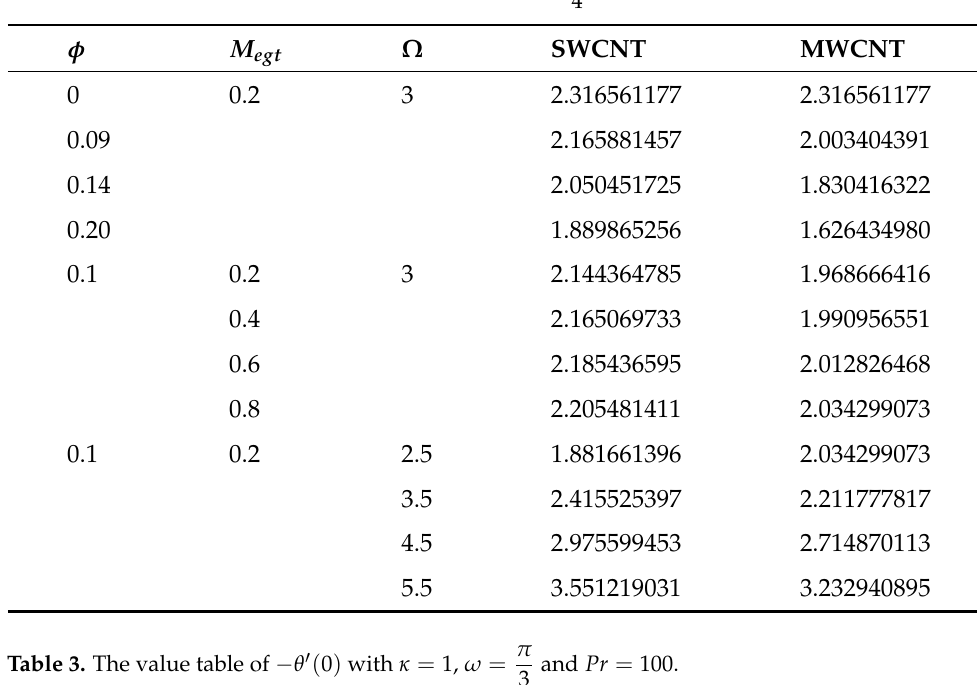
Table 2. Numerical table of − f (cid:48)(cid:48) ( 0 ) with κ = 2 and ω =